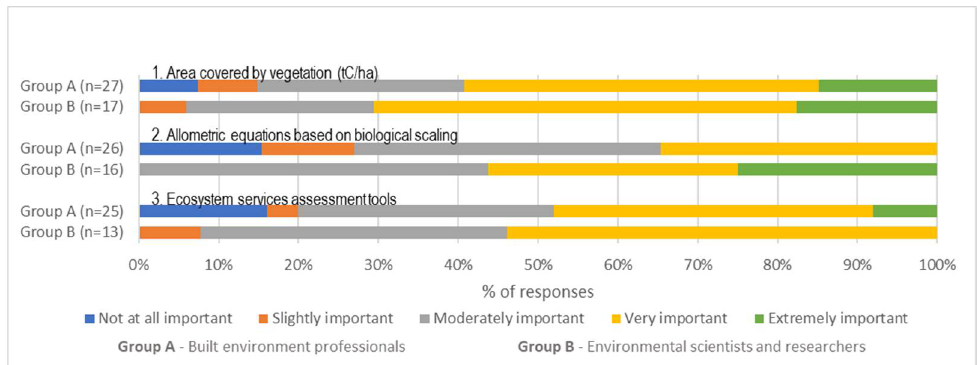
Figure 8. Frameworks for quantifying carbon sequestration rates.